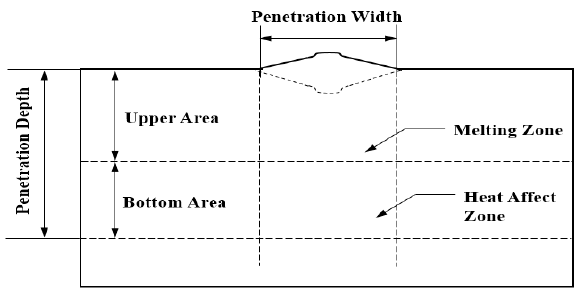
Figure 3. Schematic diagram of penetration geometry.